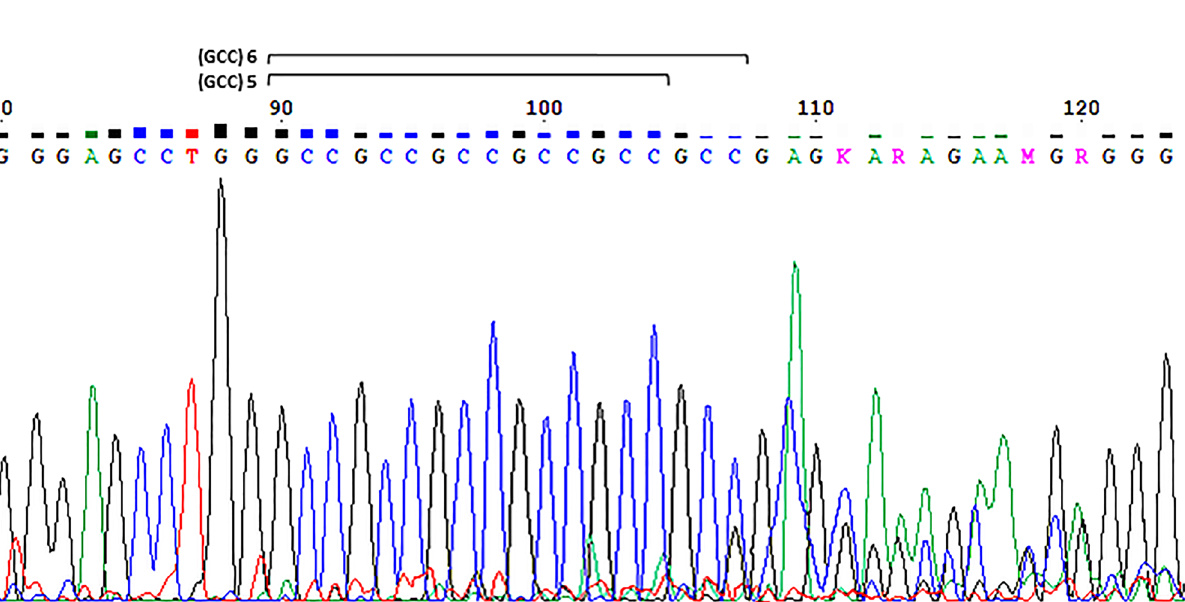
Figure 3. Identification of a genotype at the short extreme of the allele range in one instance of late-onset